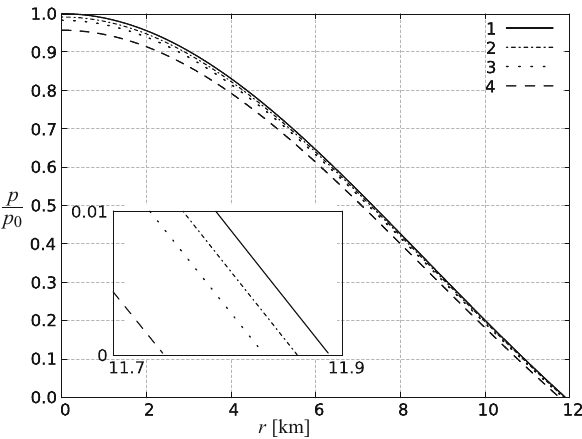
Fig. 8 Pressure profile for compact objects with ECT-inspired correc- tions and MIT-bag equation of state B = 50 MeV / fm 3 . The compar- ison is done for models that have the same classical central density ρ = 6 . 5 × 10 14 g / cm 3 . See Table 4 for details 0 with respect to the purely classical case. This is again